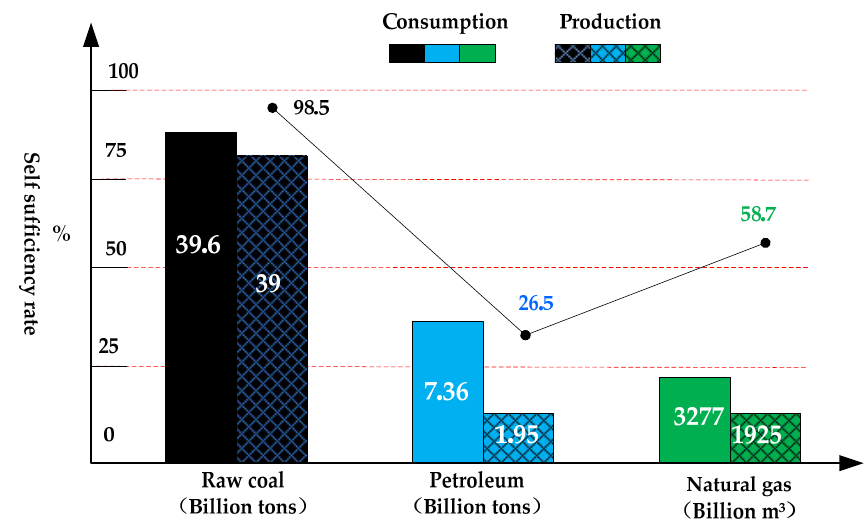
Figure 2. Comparison of China’s energy output and consumption in 2021 [13].